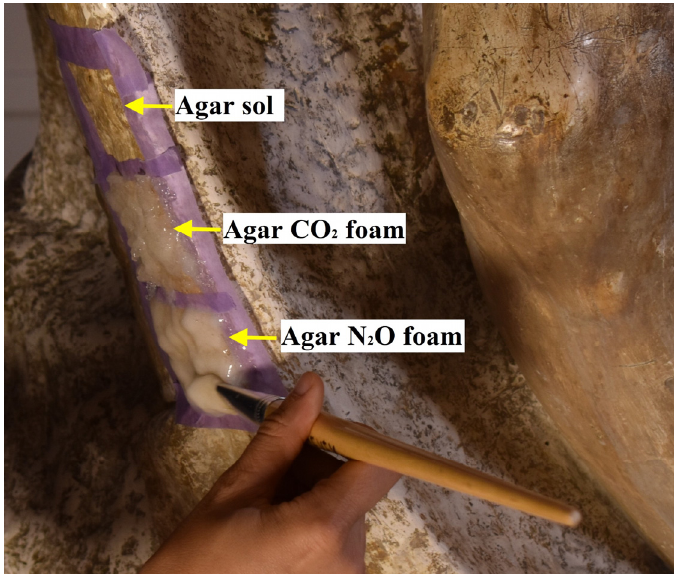
Figure 2. Application of the Agar foam to the gypsum cast of the Pietà Rondanini.